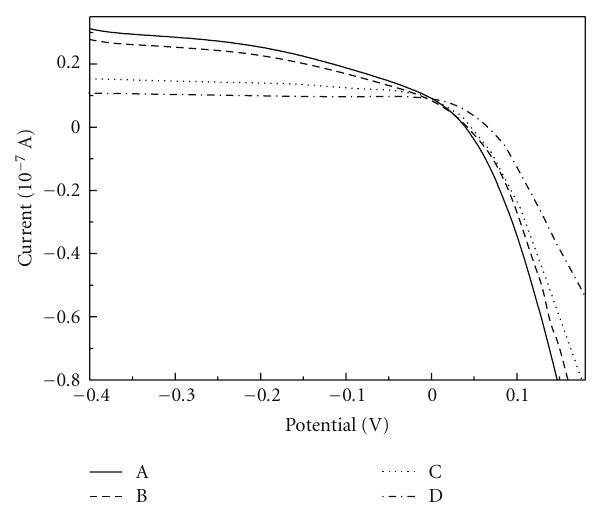
Figure 4: Steady-state voltammograms of solutions A ∼ D at 25 ◦ C. Solution component: (A) m(HEEDAI):m(MPII) = 1:9; (B) m(HEPI):m(MPII) = 1 :9; (C) m(HEEDAI):m(MPII) = 1:4; (D) m(HEEDAI):m(MPII) = 1:1, and 0.15mol · L − 1 I 2